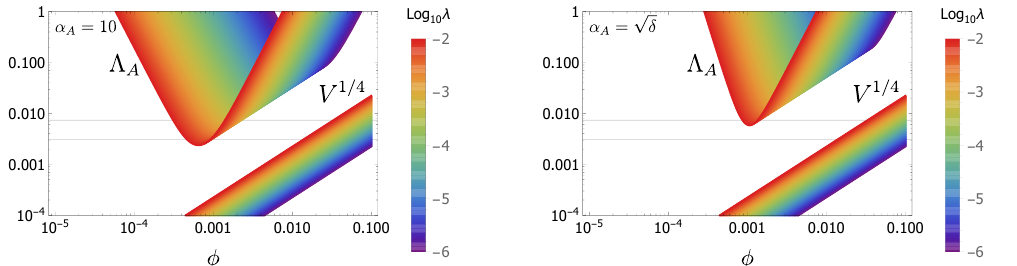
(b) Cuto(cid:11) from 2 ! 2 scattering of non-minimally coupled gauge bosons, for di(cid:11)erent non-minimal coupling (cid:11) A = 10 (left plot) and (cid:11) A =